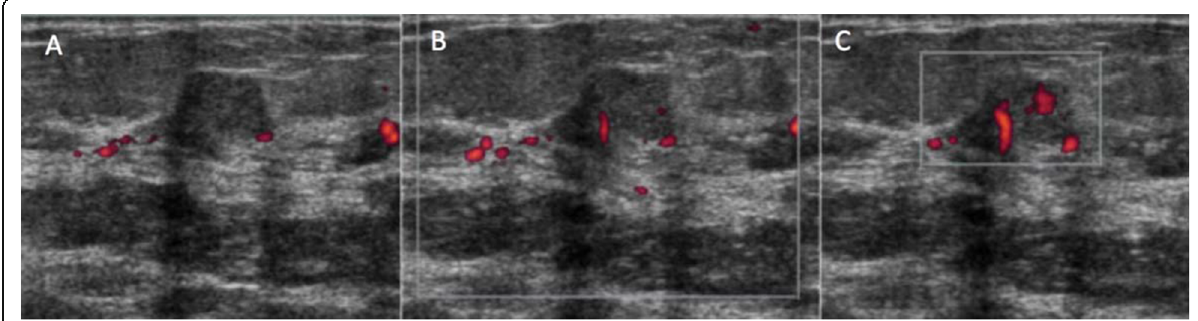
Fig. 8 Color Doppler imaging. a , c Decreasing the Doppler box size, improves the sensitivity to flow [27]